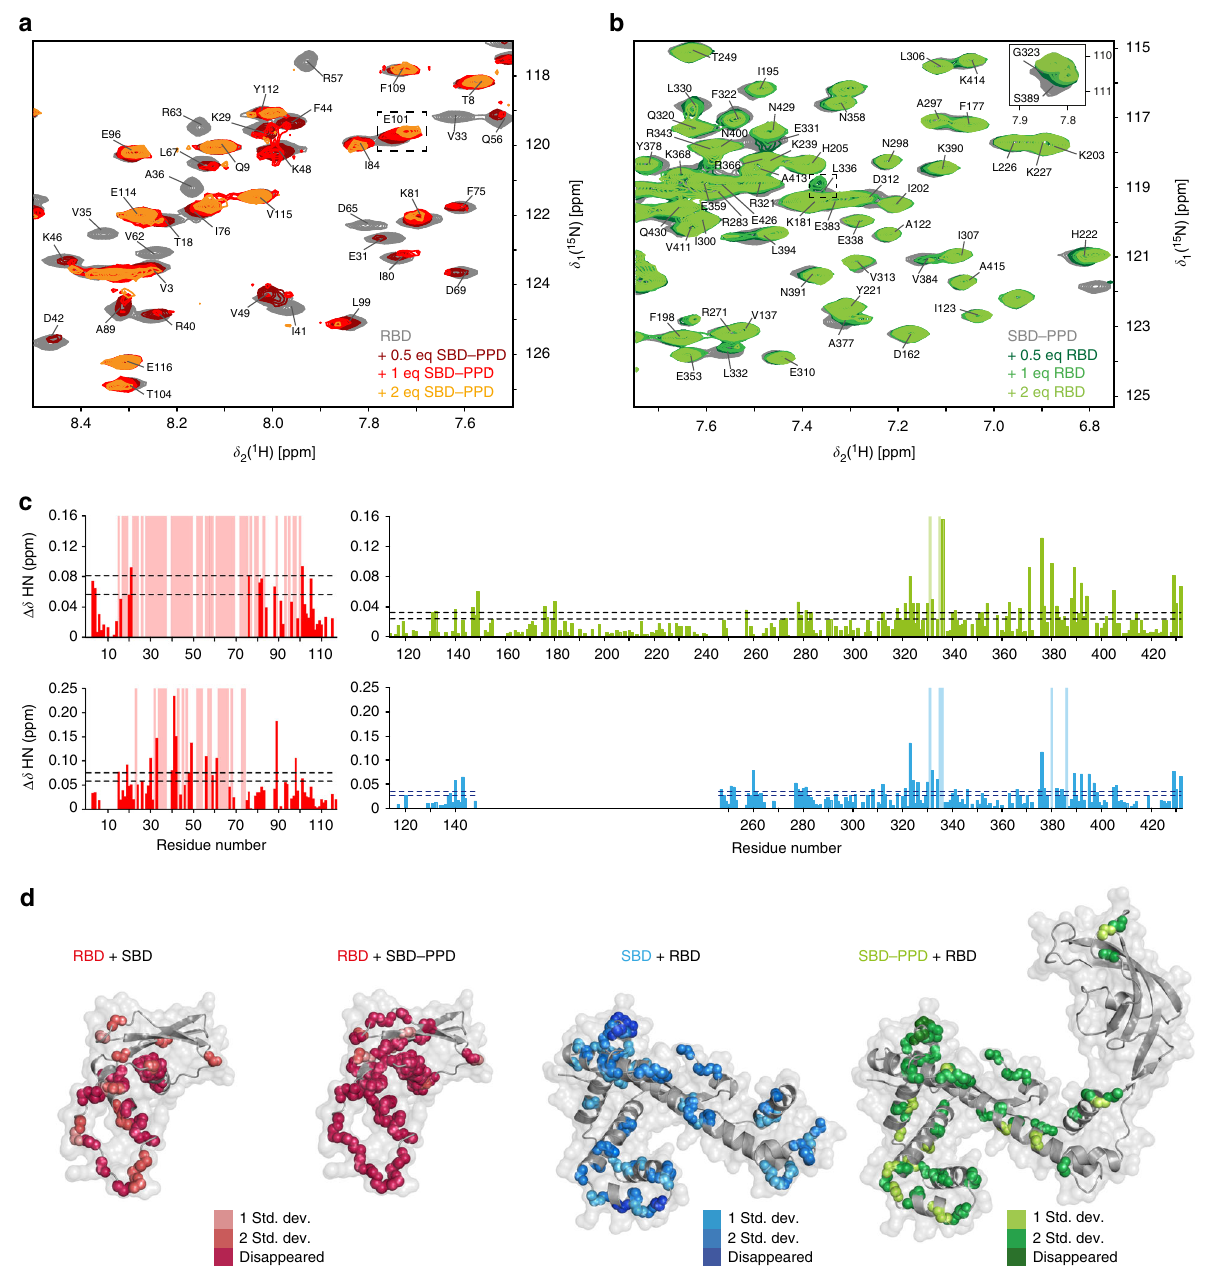
Fig. 2 Localization of pairwise interaction sites on individual TF domains. a NMR titration of unlabeled SBD – PPD to 100 μ M [ U - 15 N] RBD in sample buffer (20 mM K-phosphate pH 6.5, 100 mM KCl, 0.5 mM EDTA) at 25 °C and 700 MHz. b NMR titration of unlabeled RBD to 250 μ M [ U - 2 H, 15 N] SBD – PPD in sample buffer at 25 °C and 700 MHz. c Chemical shift perturbation of the amide moieties observed in the titrations: [ U - 15 N] RBD + SBD – PPD (top left), [ U - 15 N] RBD + SBD (bottom left), [ U - 2 H, 15 N] SBD – PPD + RBD (top right), and [ U - 2 H, 15 N] SBD + RBD (bottom right). Light-shaded bars represent peaks undergoing line-broadening. Dashed lines are plotted at de fi ned thresholds (mean value of the chemical shift perturbations plus one time and plus two times the standard deviation corrected to zero). d Signi fi cant chemical shift perturbations plotted in TF crystal structure (PDB 1W26). The affected residues are plotted with color gradient from light to dark for peaks with chemical shift changes above the threshold and that broaden beyond detection,